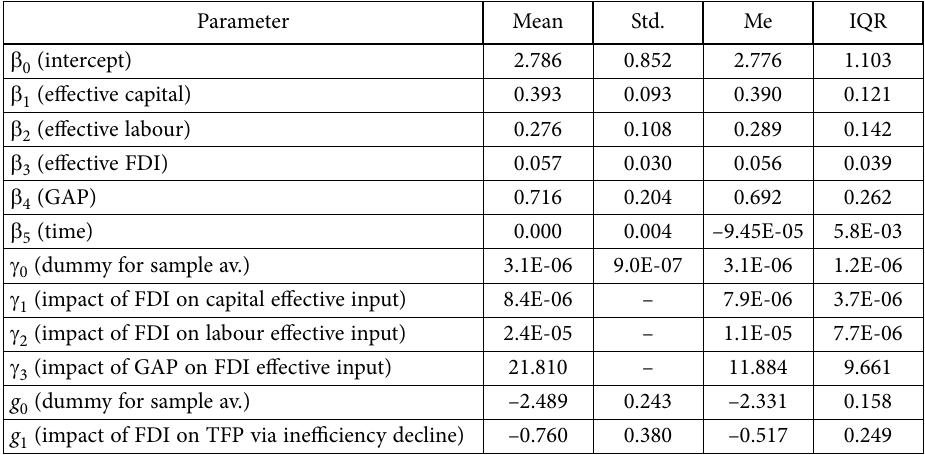
Table 2. The results of the GTRE–VED model estimation Parameter Mean